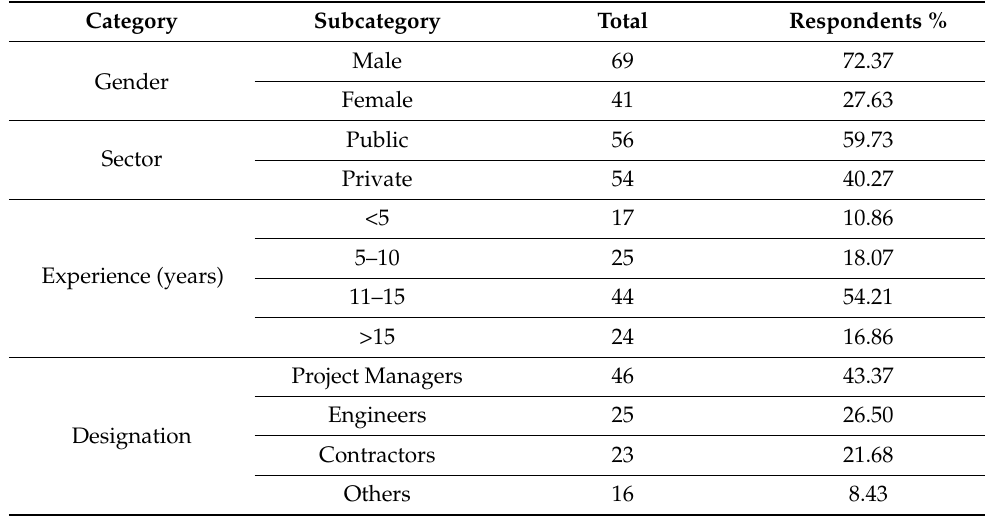
Table 2. Summary of respondents’